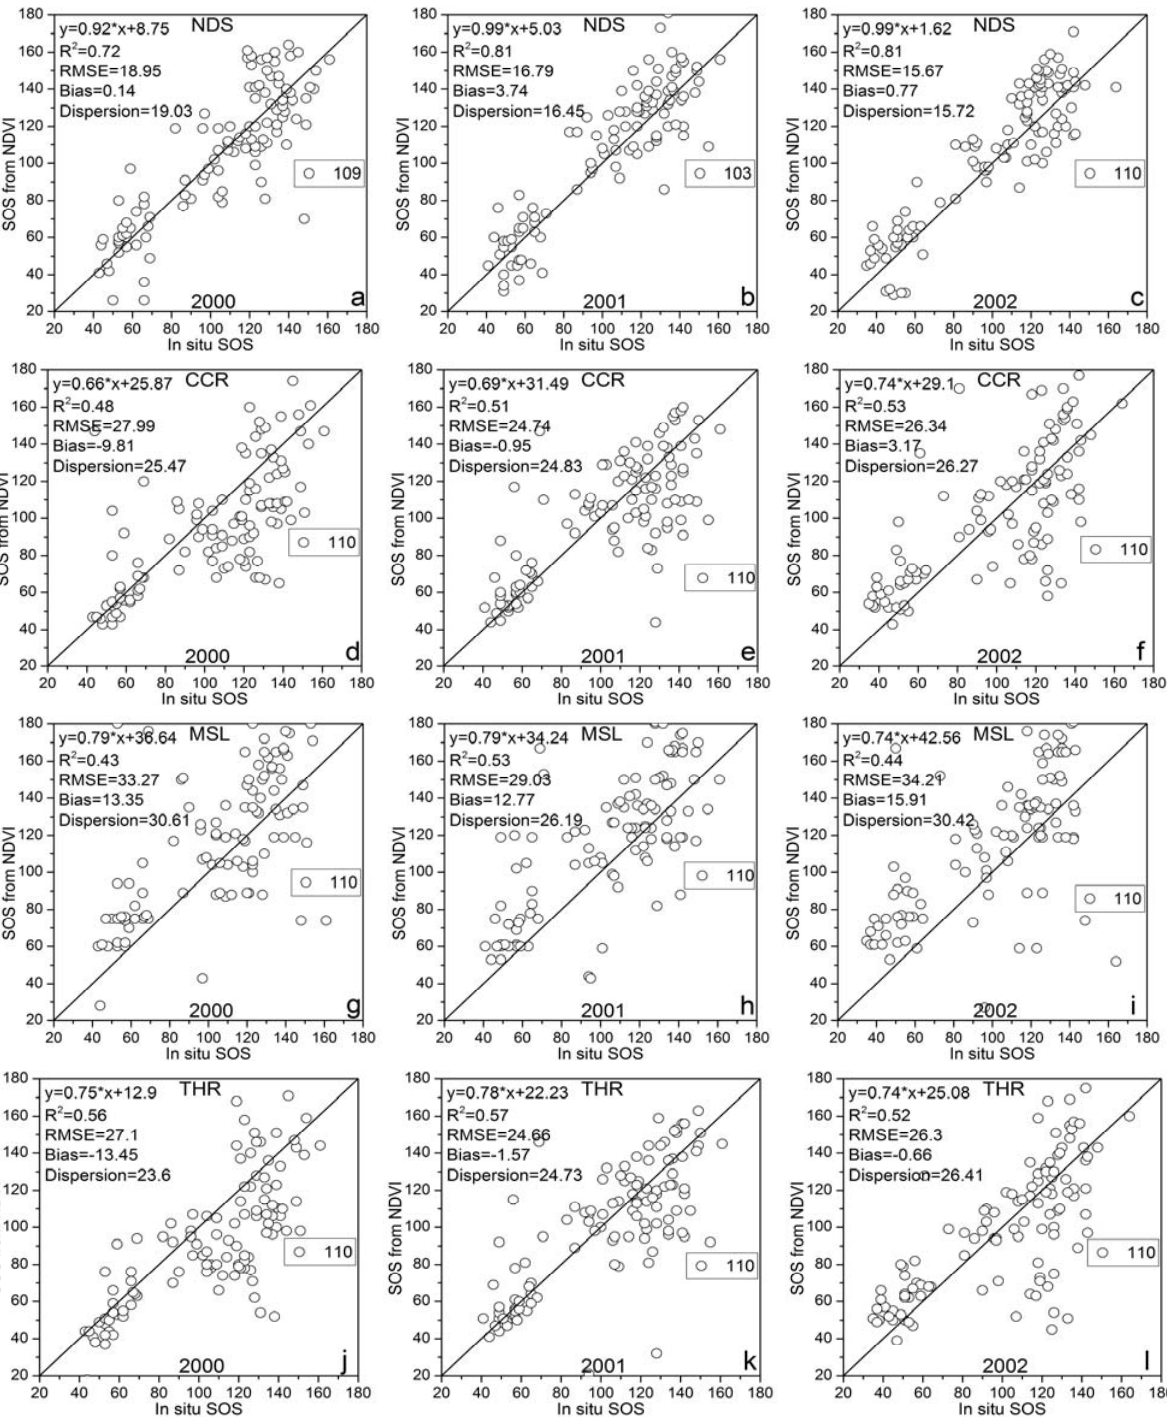
Figure 6. Comparisons of in situ SOS date (DOY) with SOS date (DOY) derived from four methods based on remote sensing data: ( a – c ) This study’s NDS